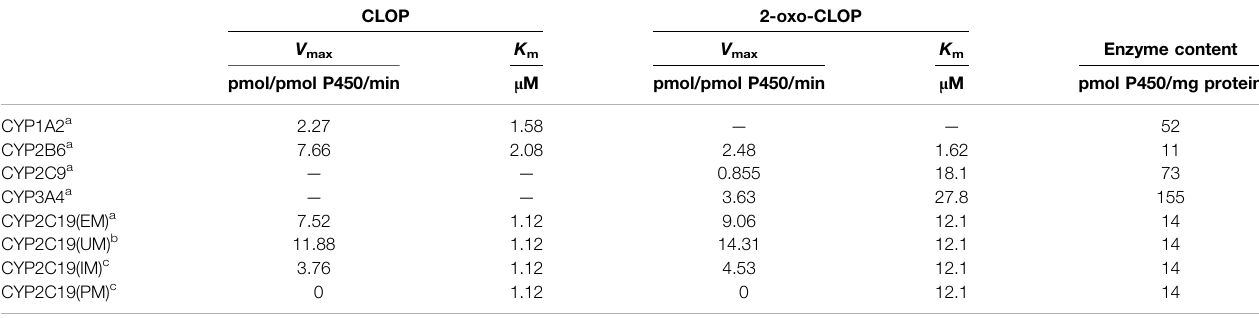
TABLE 3 | Metabolic parameters of CLOP and its metabolites used in PBPK-PD model.